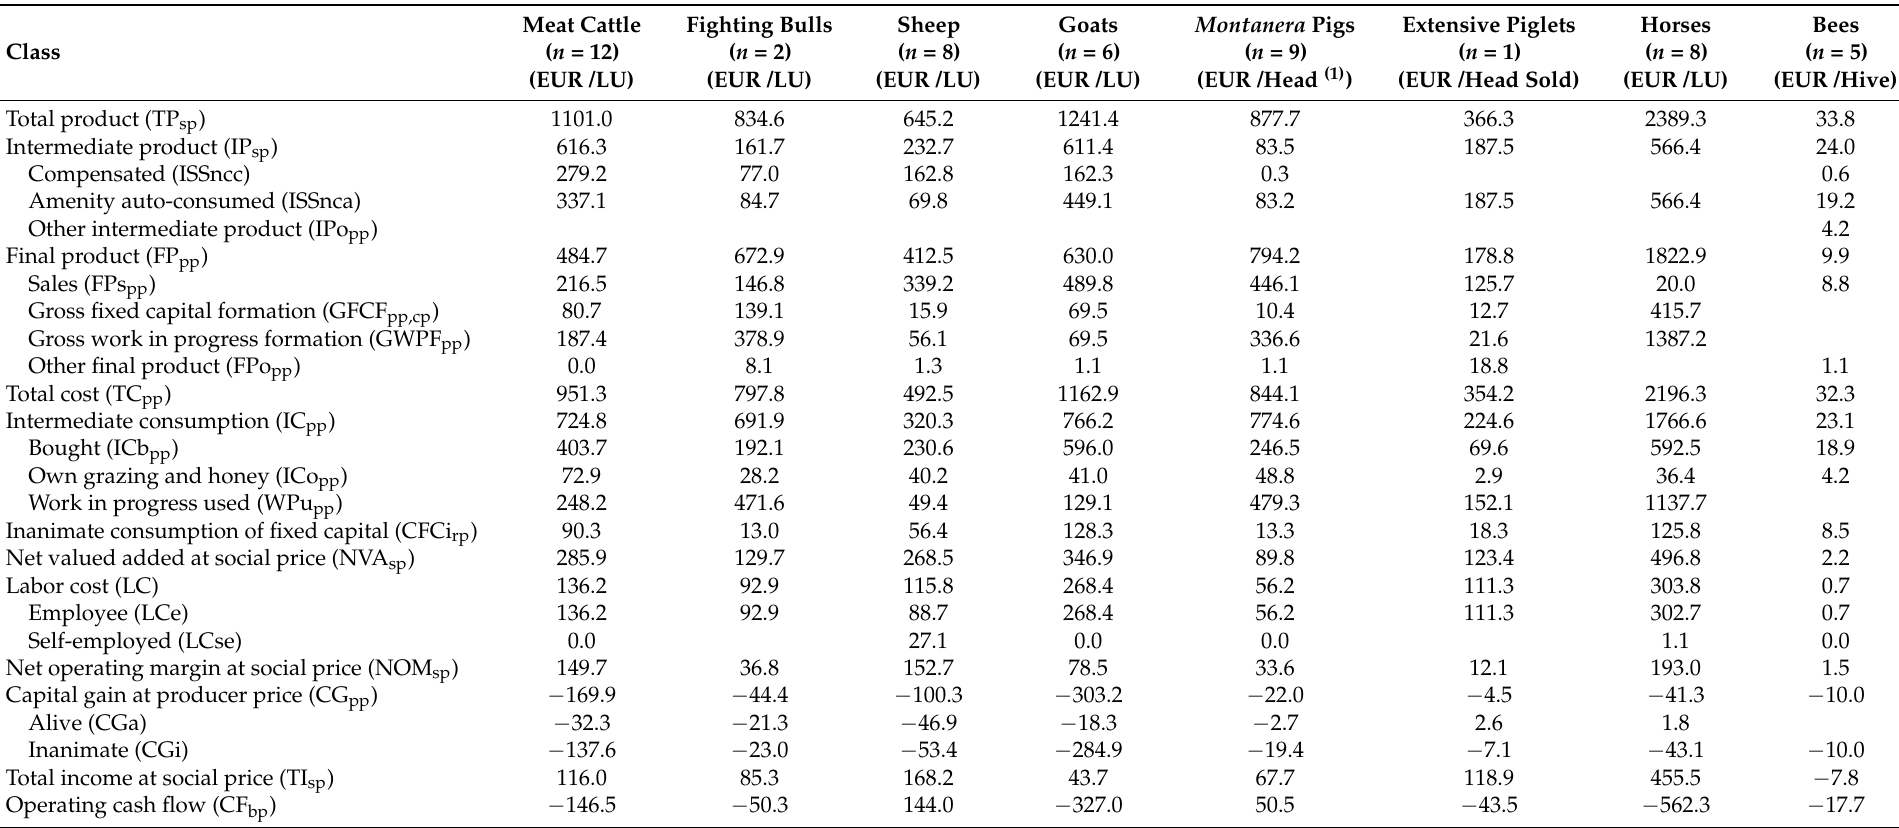
Table 5. Livestock species incomes and ordinary cash flows for large privately owned case-study dehesas in Andalusia under the Agroforestry Accounting System (AAS) (2010: EUR/u).